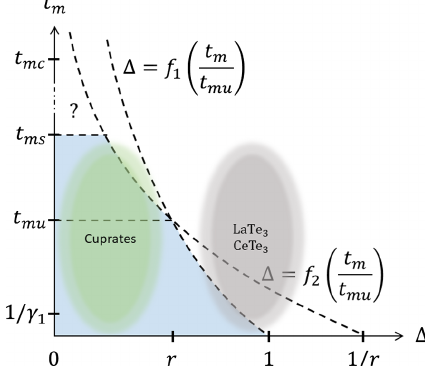
FIG. 5. A schematic “ phase ” diagram delineating the behavior = ð γ 1 α 1 on the cooling time t versus Δ ¼ γ 2 α 2 plane. The m L L Þ horizontal axis can be viewed as γ 2 , while all other parameters are fixed. In the blue region, trapping into phase I happens because h ψ 2 2 i = h ψ 2 1 i < 1 at t c . The region t m > t ms is unexplored in this paper and discussed in Sec. V B. The green (gray) ellipses are our tentative guess of where the cuprates (rare-earth) tritellurides lie on this